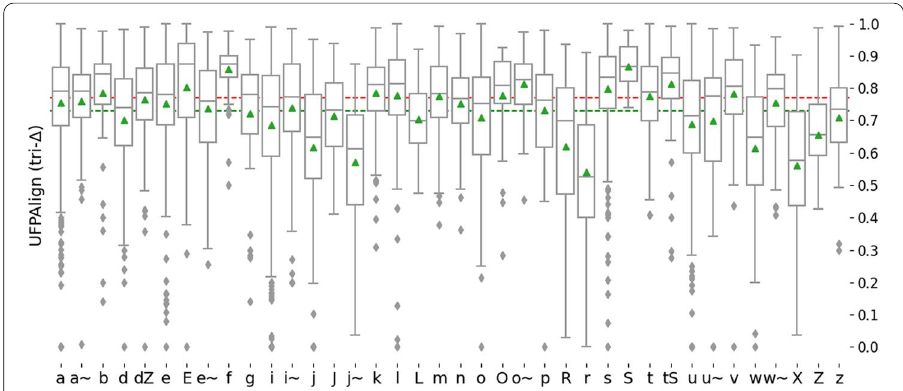
Fig. 10 IoU values per phoneme on the utterances of the female speaker regarding the tri- (cid:31) acoustic model trained with Kaldi